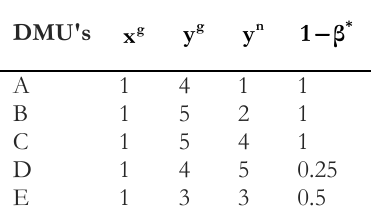
Table 2. The inputs and outputs data for 5 DMUs by model